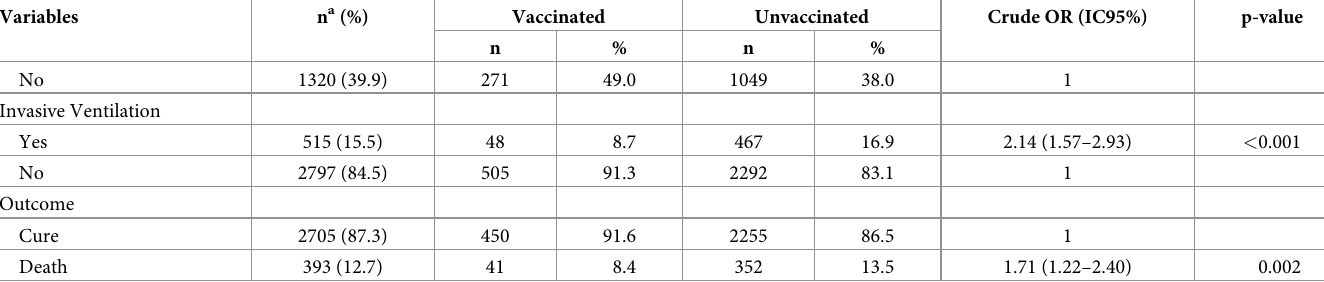
The univariate analysis showed an association with vaccination status: dyspnea (OR: 1.57;